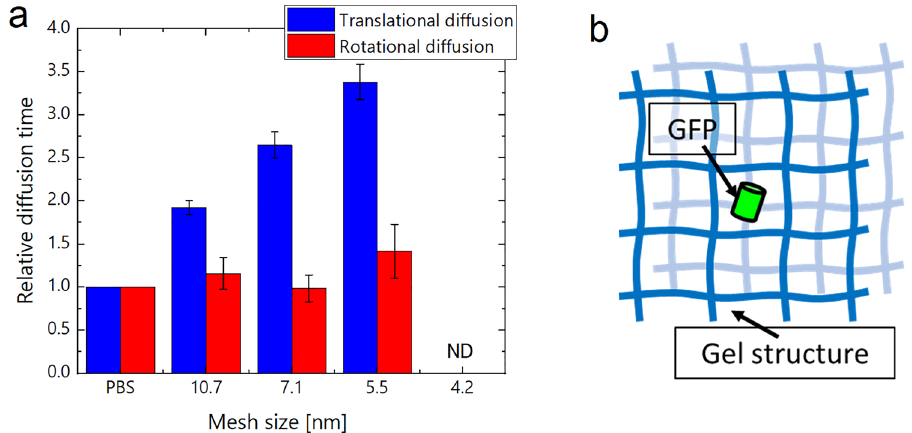
Figure 2. Pol-FCS measurement of GFP in gels. ( a ) Relative rotational/translational diffusion times. The sample with the mesh size of 4.2 nm could not be measured because GFP could not enter the gel. ( b ) GFP in gel structure.